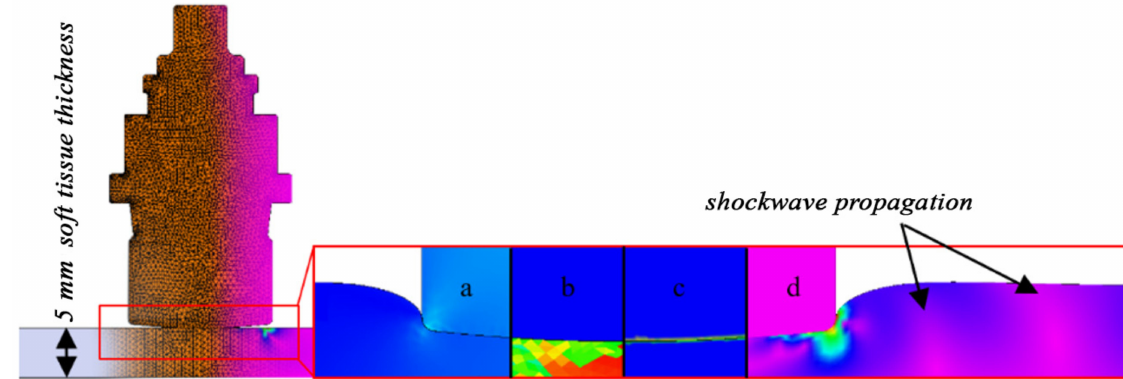
Figure 6. Nonlinear dynamic simulation and general results overview; ( a ) von Mises stress, ( b ) total strain energy, ( c ) contact pressure, ( d ) shockwave propagation